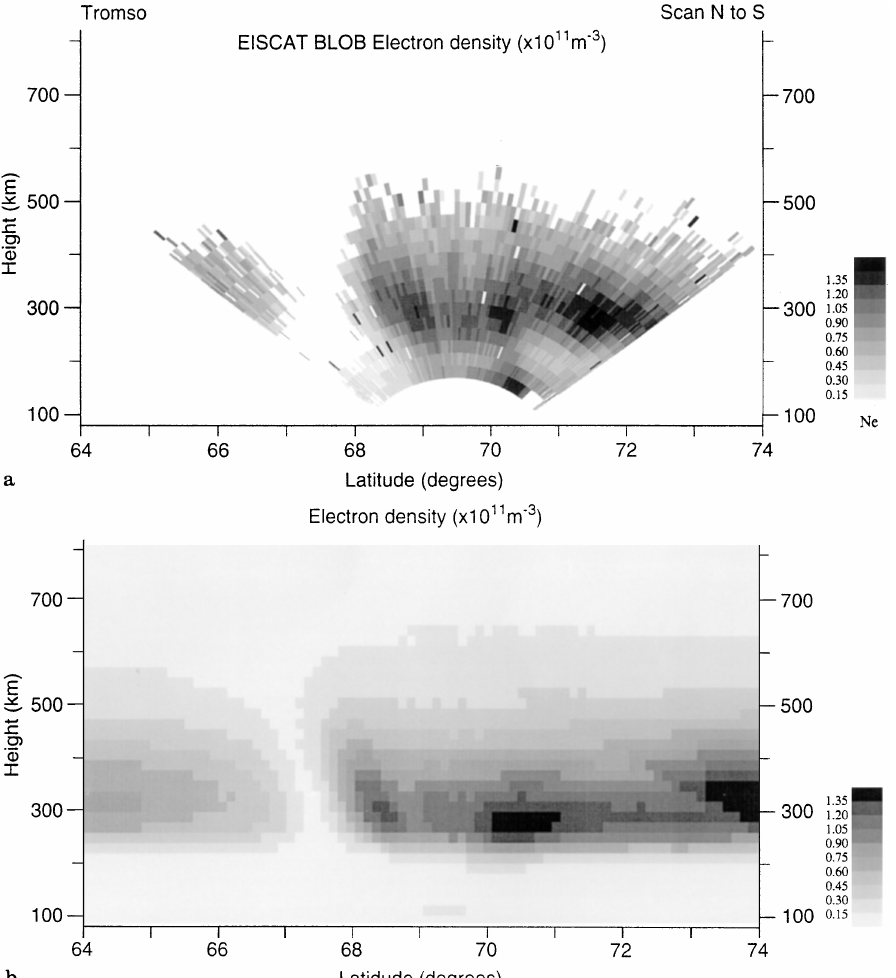
Fig. 5. a Electron-density measure- ments made by EISCAT during a scan of SP-UK-BLOB between 2102 and 2128 UT on 15 October 1993; b tomographic image of elec- tron density for a satellite pass at 2136 UT on 15 October 1993. (after colour plots presented by Mitchell et al .,